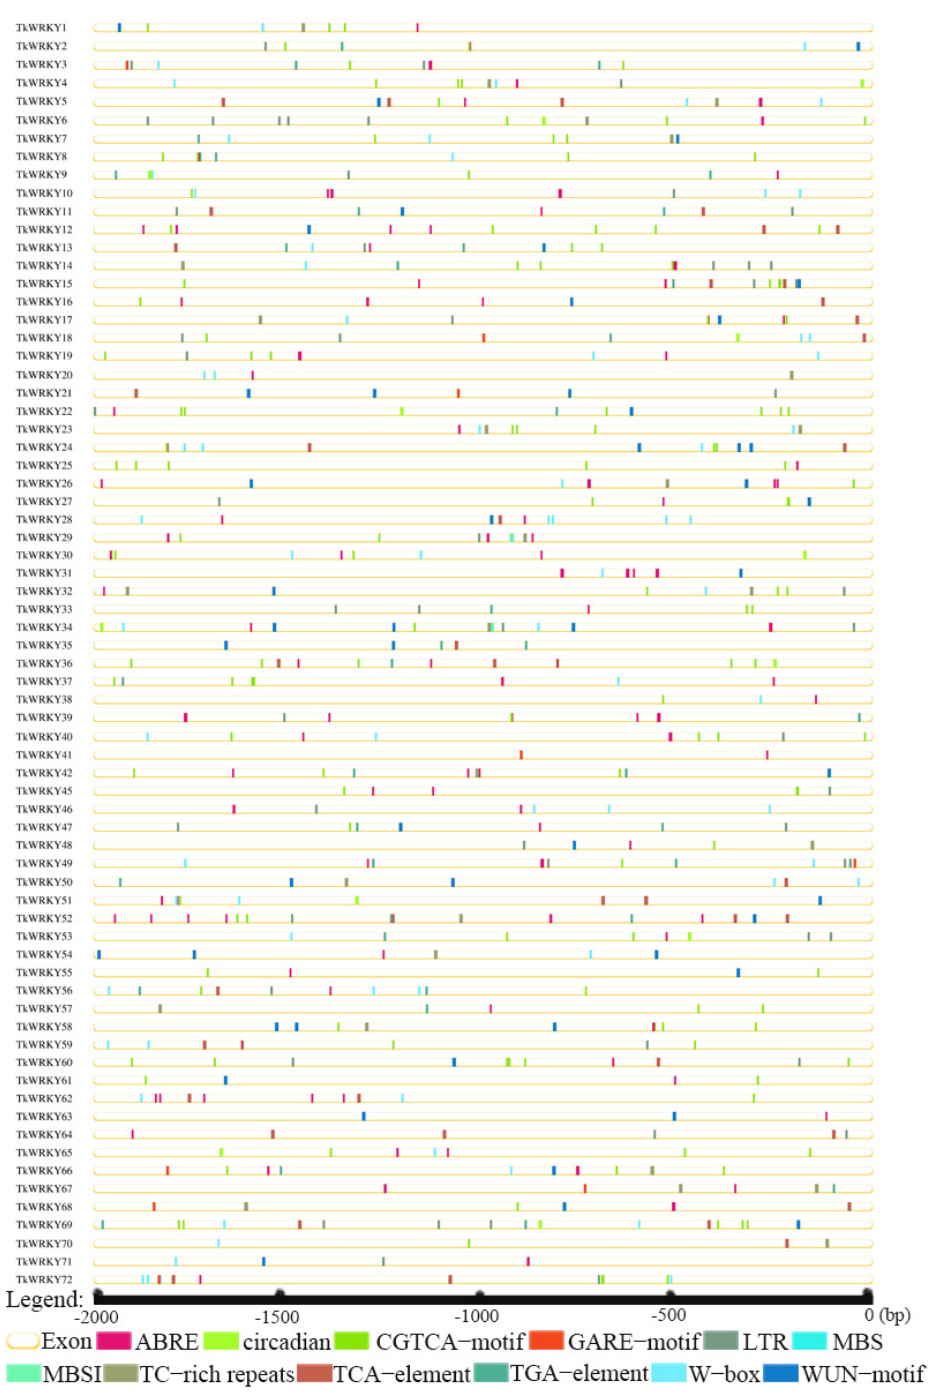
Figure 6. Location distribution of different types of cis -elements in the TkWRKY promoter region; the 12 differently colored lines correspond to 12 different cis -elements.